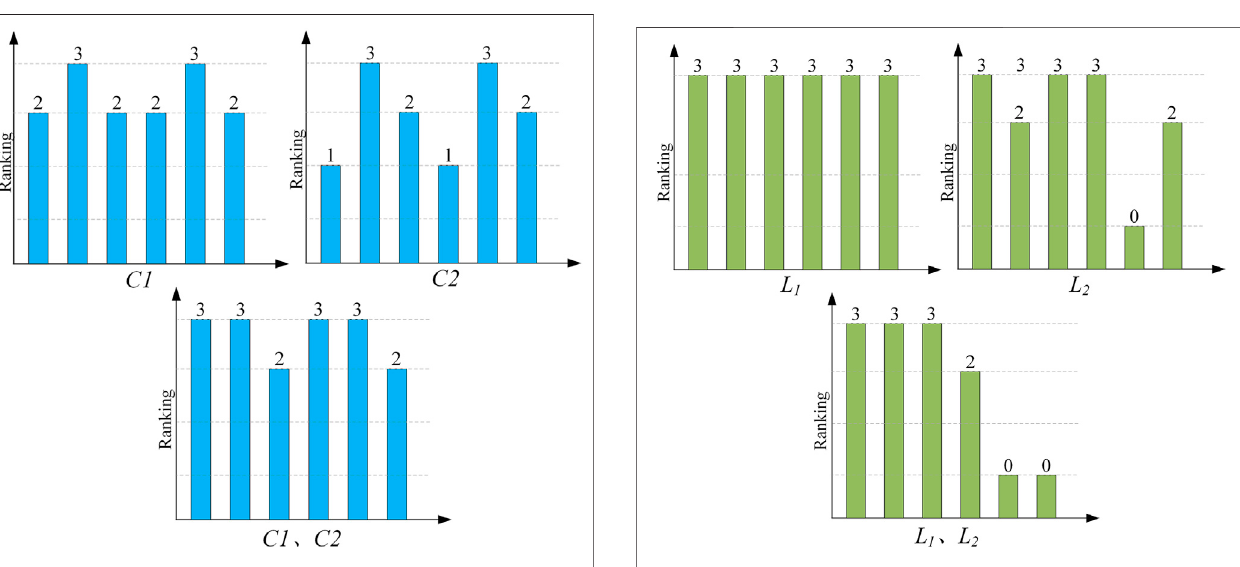
FIGURE 11 | Code diagram of short-circuit defect code of horizontal cable sheath section.